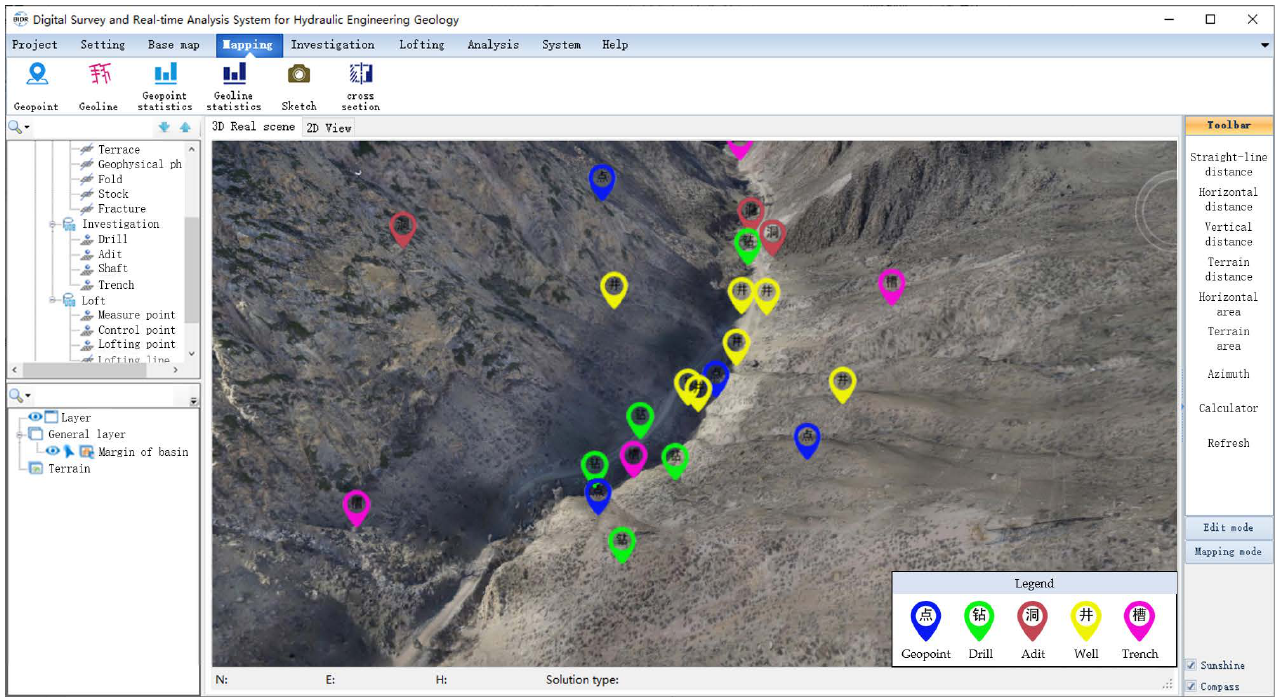
Figure 15. Results of a geological